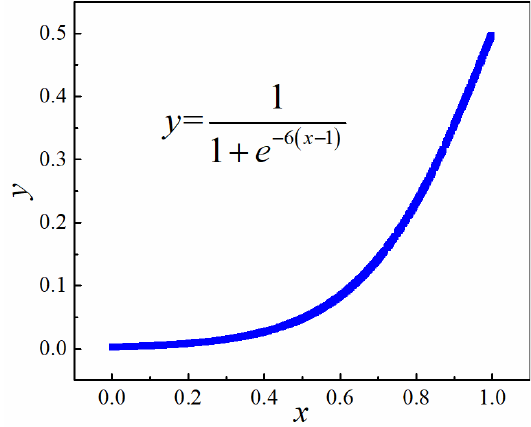
Figure 8. Function curve in sigmoid form.